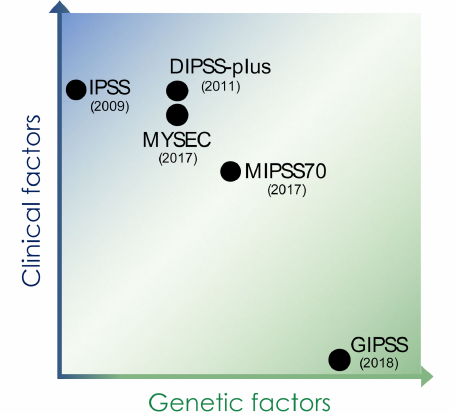
Figure 2. Prognostic scoring systems for myelofibrosis. Early prognostication schemes for myelofi- brosis relied on clinical factors including age, hematologic parameters including cytopenias and blast count, and symptoms, while more recent scores have increasingly implemented genetic factors such as information on cytogenetic features, driver mutations, and concomitant somatic mutations of prognostic impact. IPSS: international prognostic scoring system, DIPSS: dynamic international prognostic system, MYSEC: myelofibrosis secondary to PV and ET-prognostic model, MIPPS70: mutation-enhanced international prognostic score system (validated up to 70 years of age), GIPSS: genetically inspired prognostic scoring